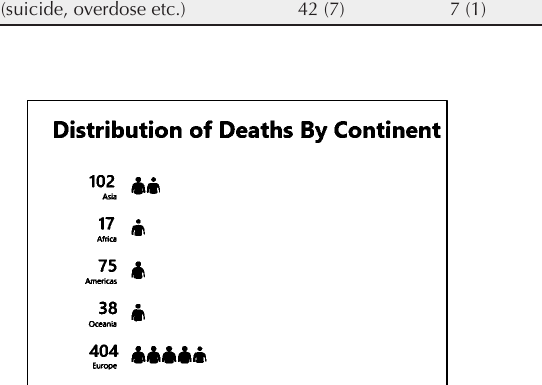
Figure 2. Distribution of Deaths by Continent.